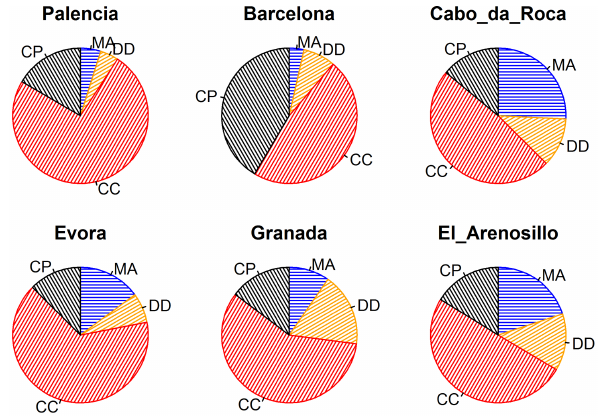
Figure 3. Relative frequency of aerosol type occurrence: maritime (MA), desert dust (DD), continental clean (CC), and continental polluted (CP) for the six sites studied.